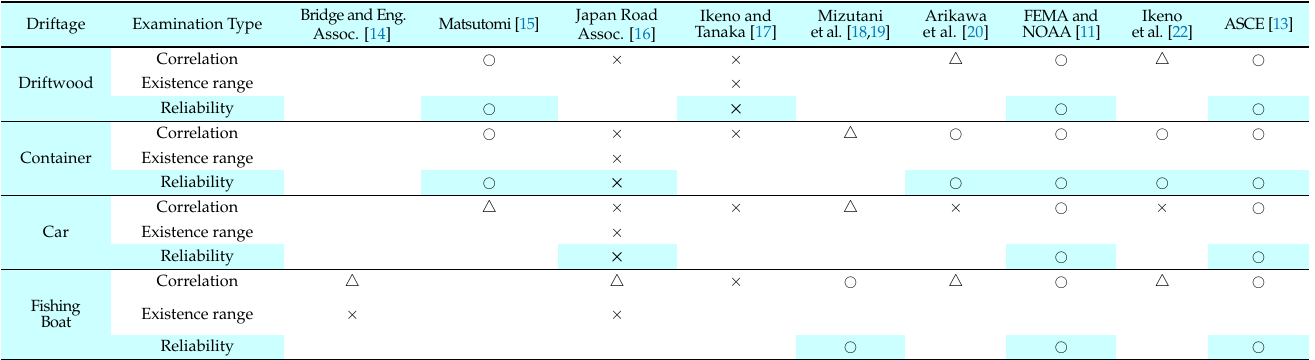
( 〇 indicates “good”, △ indicates “ordinary”, and × indicates “bad”). indicates “good”, (cid:52) indicates “ordinary”, and × indicates